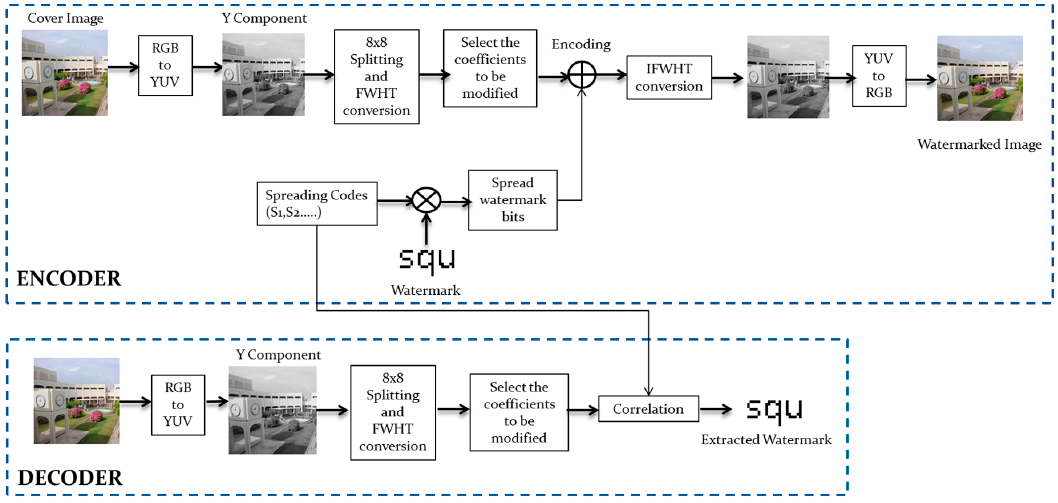
Figure 2. Embedding and Decoding procedure.